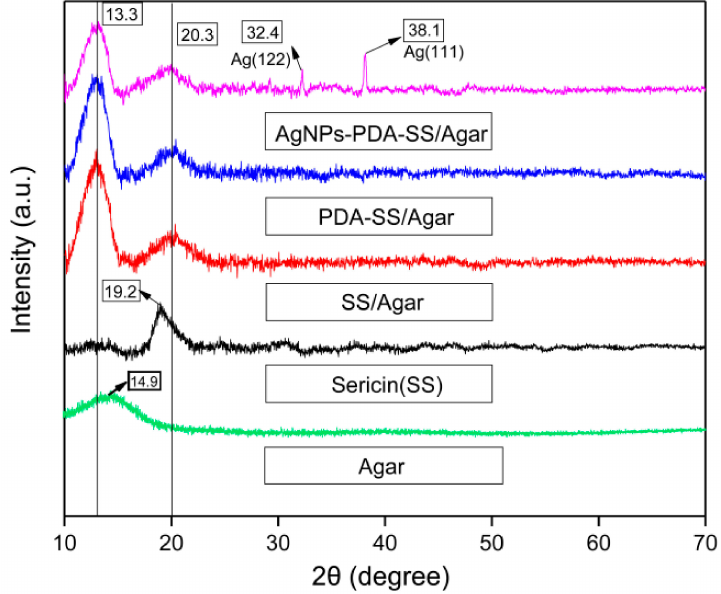
Figure 4. XRD patterns of Agar, Sericin (SS), SS/Agar, PDA-SS/Agar and AgNPs-PDA-SS/Agar